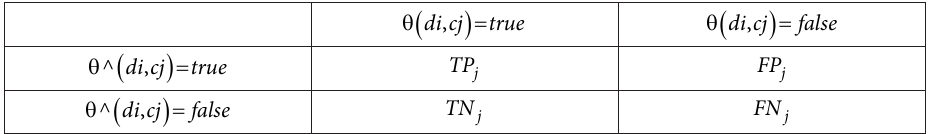
Table 3. Pivot Table for classification of test sample (source: Delina & Packová, 2013)